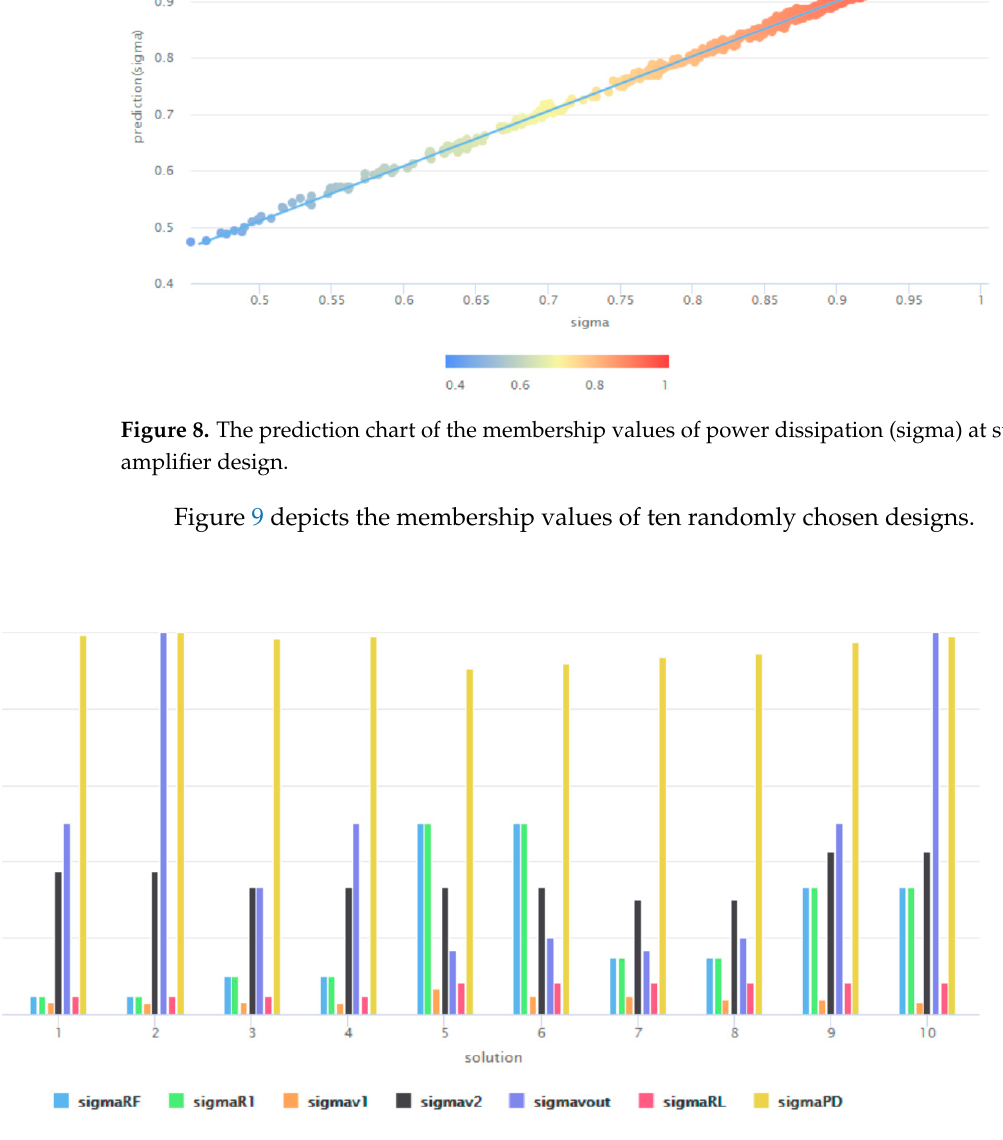
Figure 9. Membership values of randomly chosen solutions at design of subtracting amplifier.